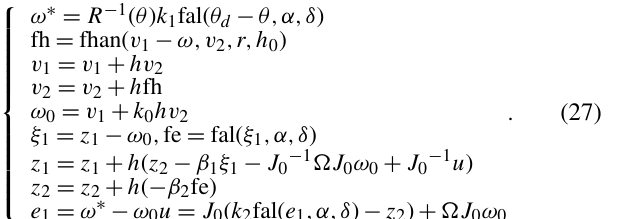
Table 2. Parameters of the inflatable tether net